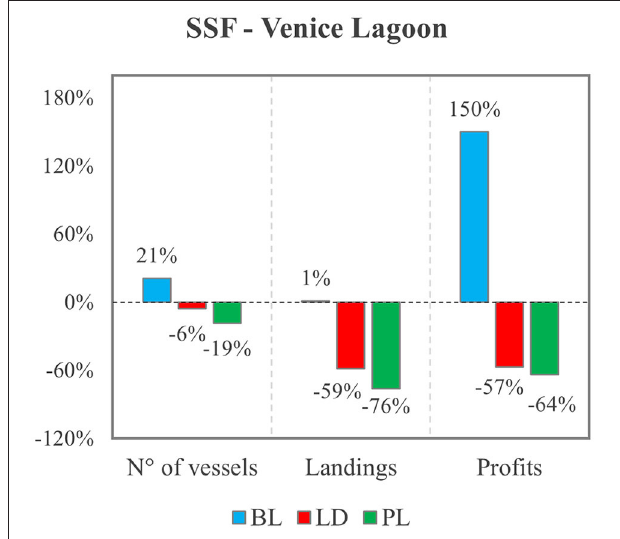
FIGURE 8 | Percentage differences between 2019 and 2020 during the three periods (BL: before lockdown, LD: lockdown, and PL: post-lockdown) considering the number of active vessels, landings, and profits of the Venice lagoon SSF